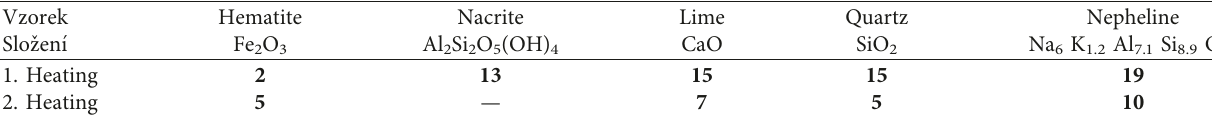
Table 6: Analysis of the crystalline phase after the 1st and 2nd